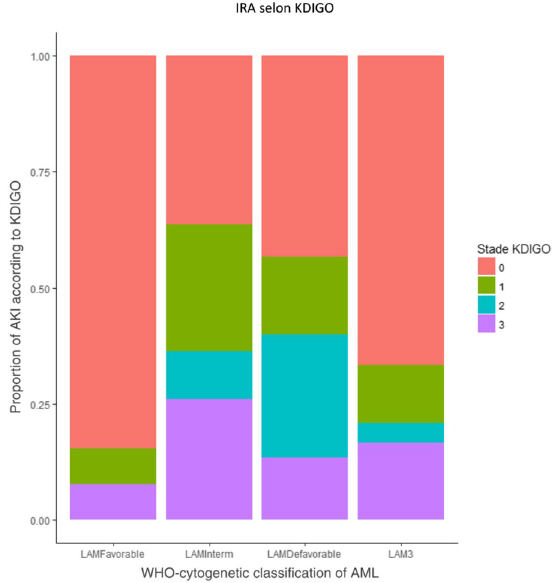
Fig. 1 AKI according to WHO‑cytogenetic classification of